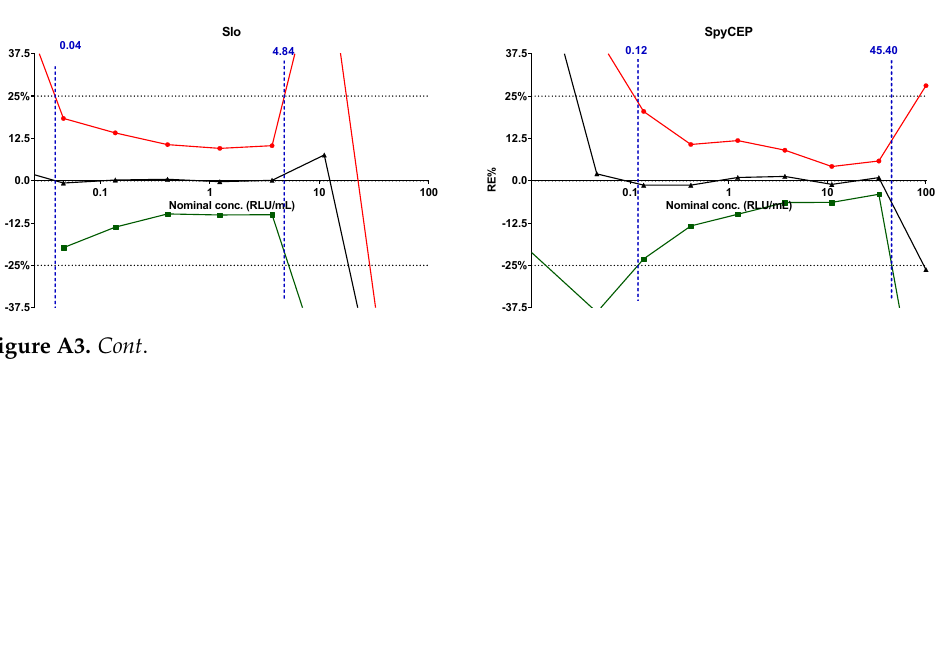
Figure A3. Accuracy assessment. % relative error (black line) with 90% upper(red) and lower (green line) confidence intervals, against nominal concentration of standard curve from 12 independently performed assays. From the plotted values the upper and lower limits of standard curve accuracy could be interpolated from with a conservative threshold where there is a 90% probability that the relative error is <25%. Figure A4. Suggested 96 well plate layout for testing of clinical samples in future human vaccine trials and seroepidemiological studies. C = positive control, B = blanks. References 1.